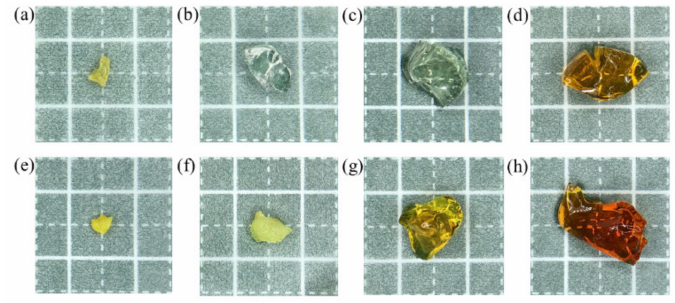
Figure 5. Photo images of IPN 1b(0.2) ( a – d ) and IPN 2b(0.2) ( e – h ); the dried gels ( a , e ), the organogels in the absence of TBAX ( b , f ), in the presence of acetate ( c , g ) and fluoride ions ( d , h ) in